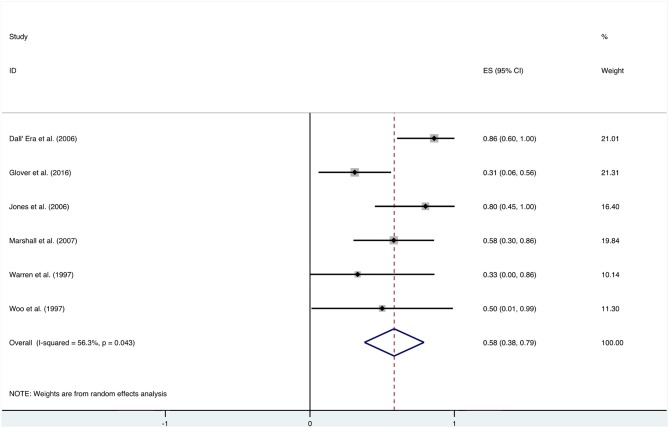
Forest plot of pain.